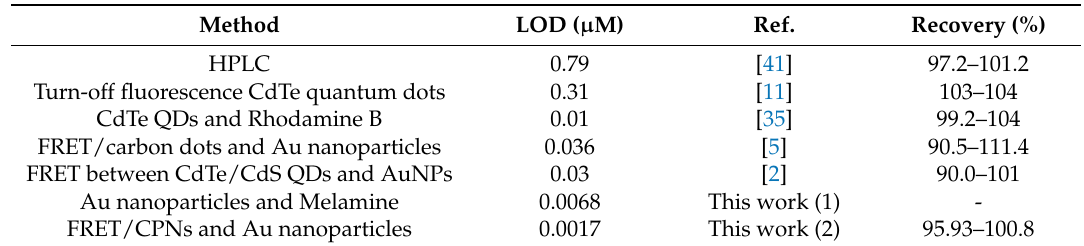
Table 1. Comparison of different methods for the determination of melamine.